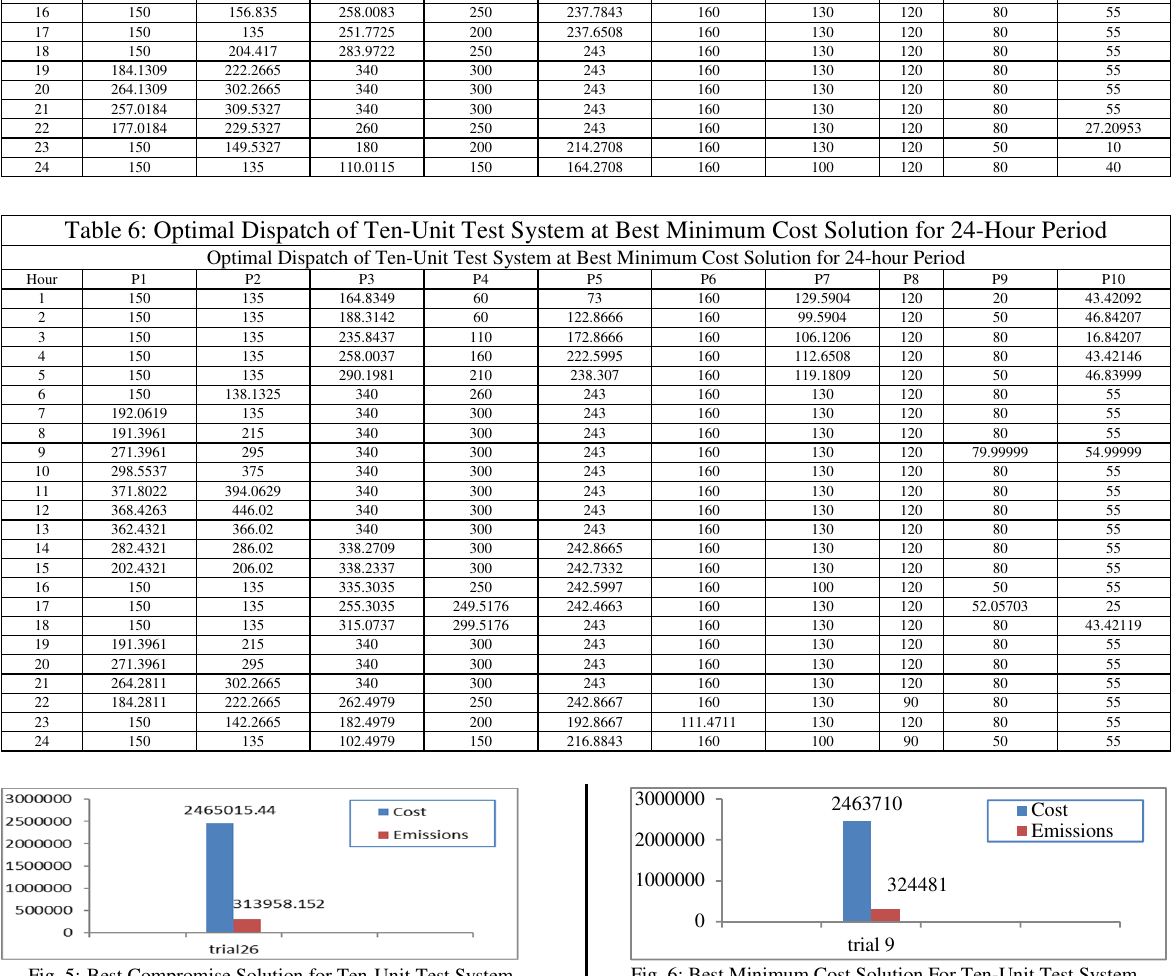
Fig. 5: Best Compromise Solution for Ten-Unit Test System Fig. 6: Best Minimum Cost Solution For Ten-Unit Test System